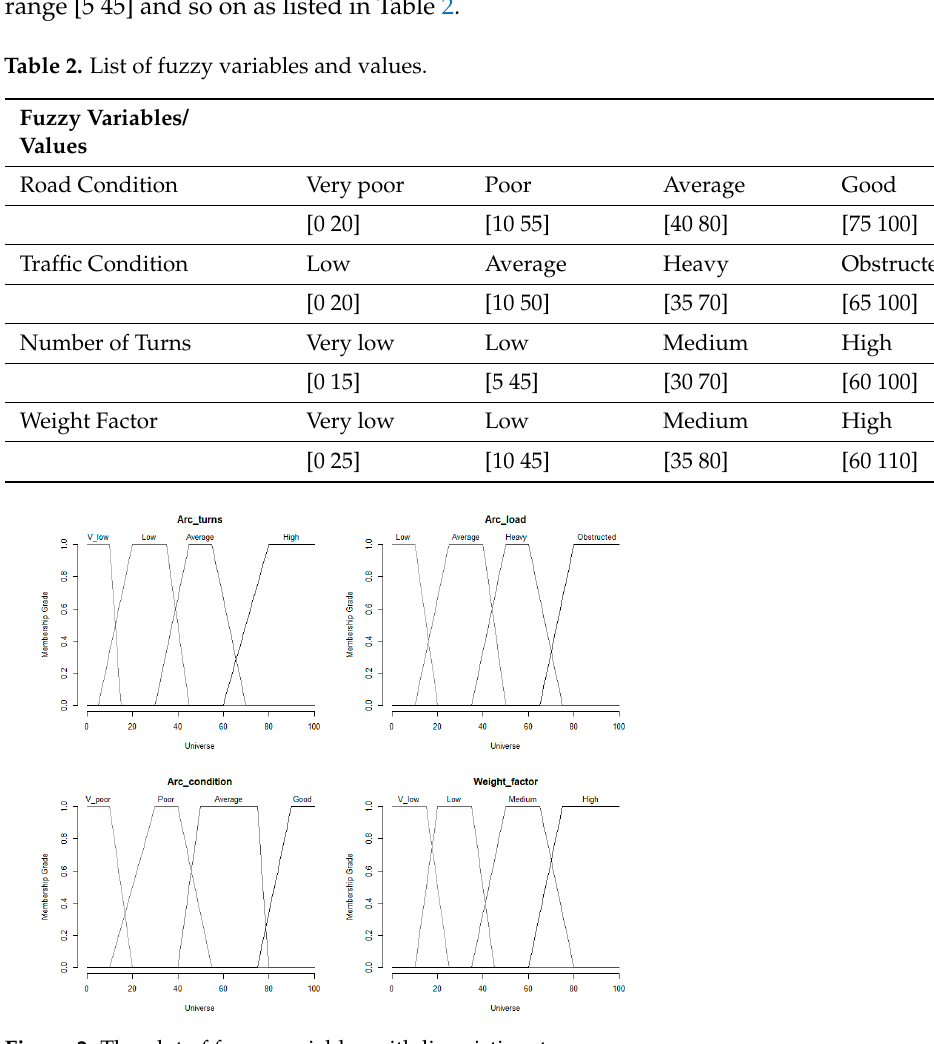
Figure 2. The plot of fuzzy variables with linguistic sets.